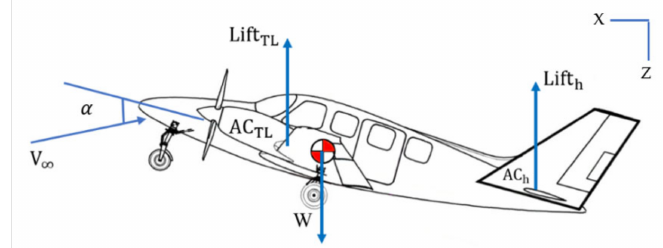
Figure 2. Longitudinal forces around the centre of